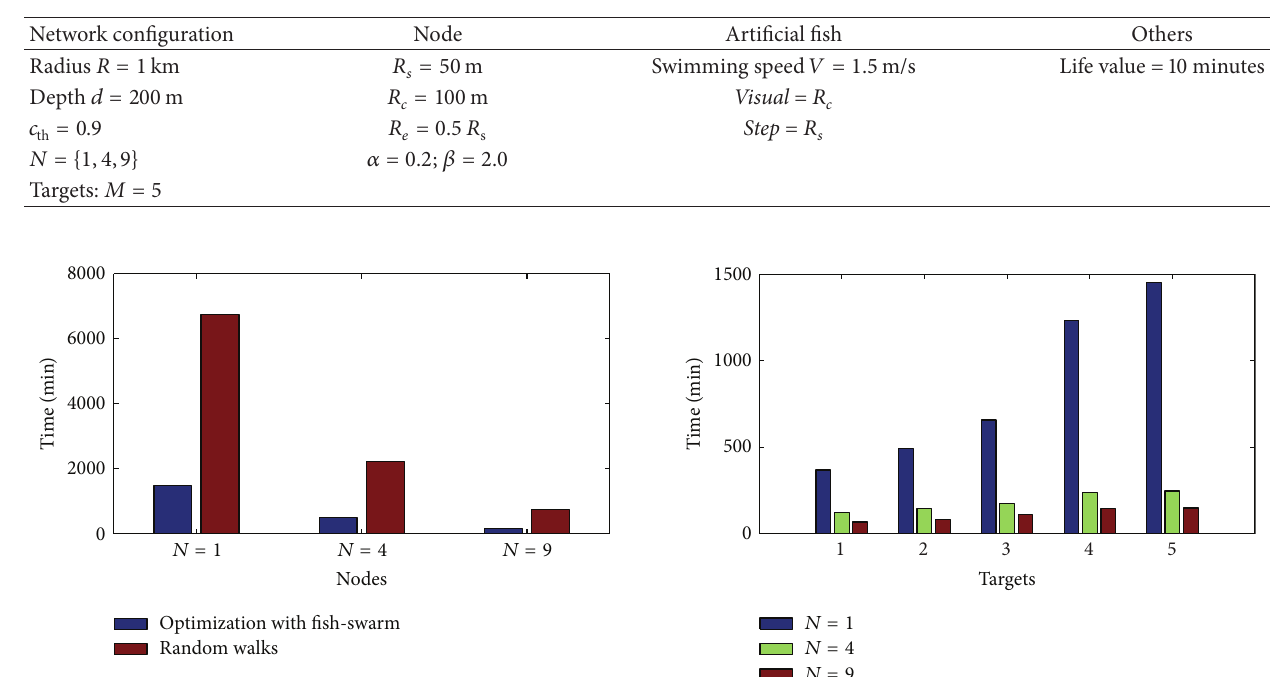
Figure 9: Overall searching time versus node number.